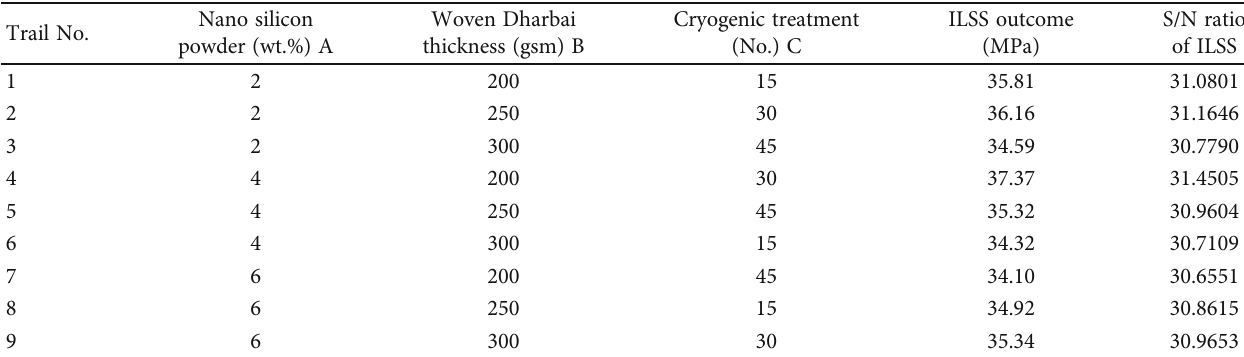
Table 2: L9 orthogonal array and experimental results.